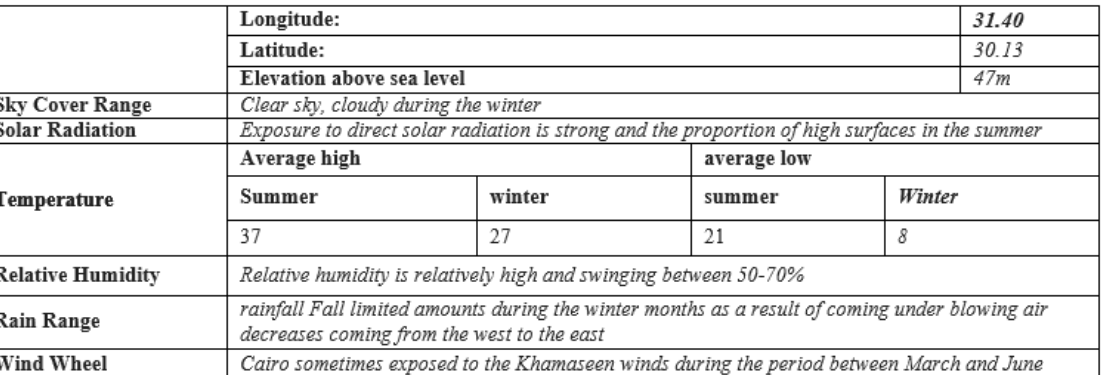
Table 2: Climate Zone characteristics